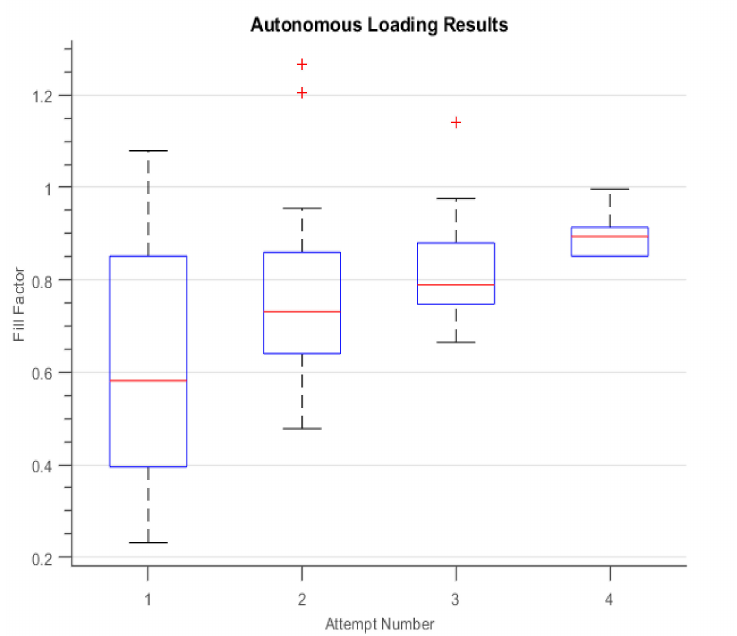
Figure 25. Progressive fill factor across loading attempts. Red “+” signs represent